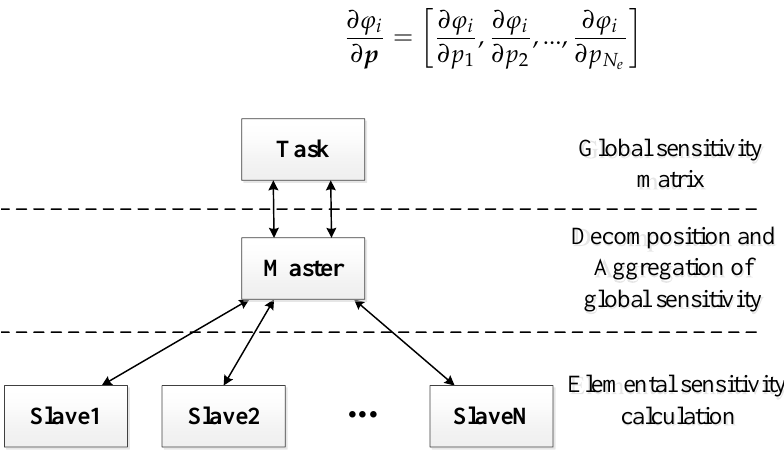
Figure 4. Sketch map of the parallel method of the master-slave